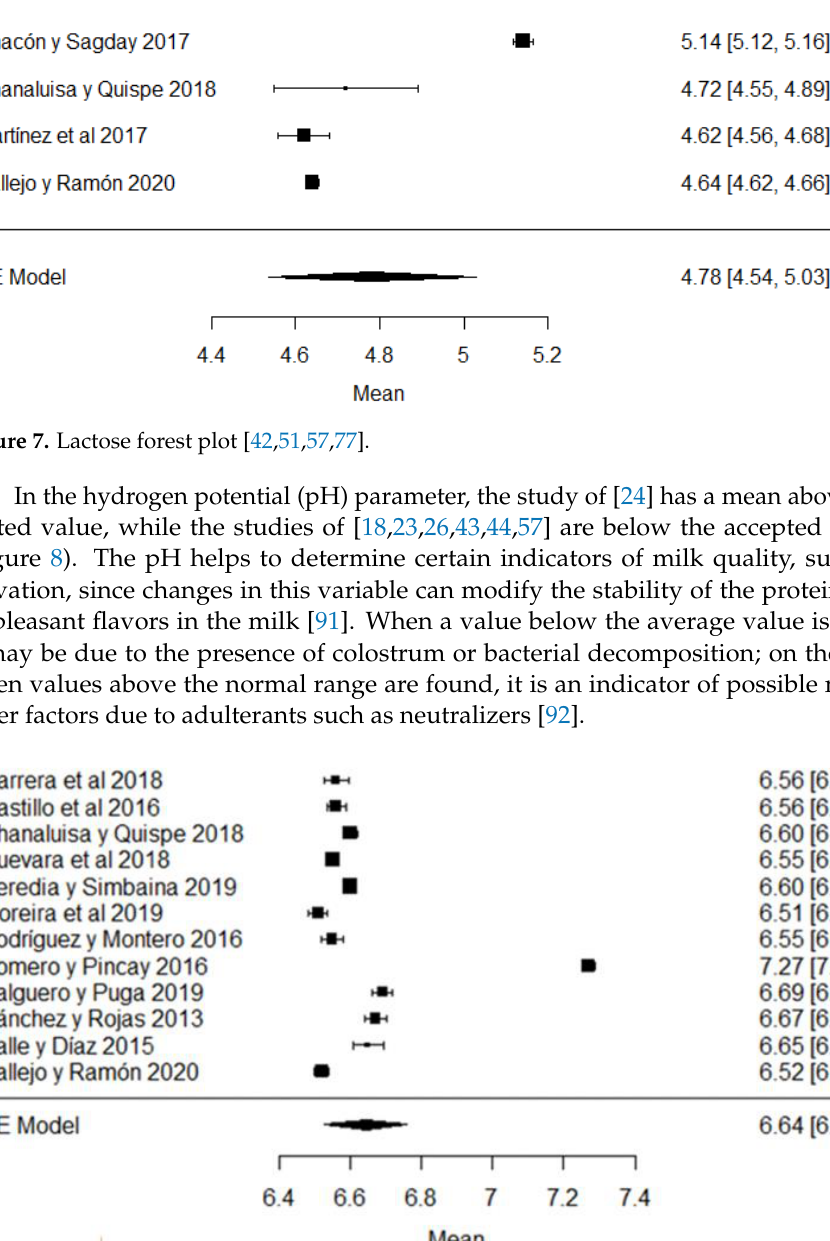
Figure 9. Forest plot of protein [14,16 – 18,21,23,24,26,28,30,33,35,38,39,42,44,51,53,57,60,61,63,64,76,77,79,80].